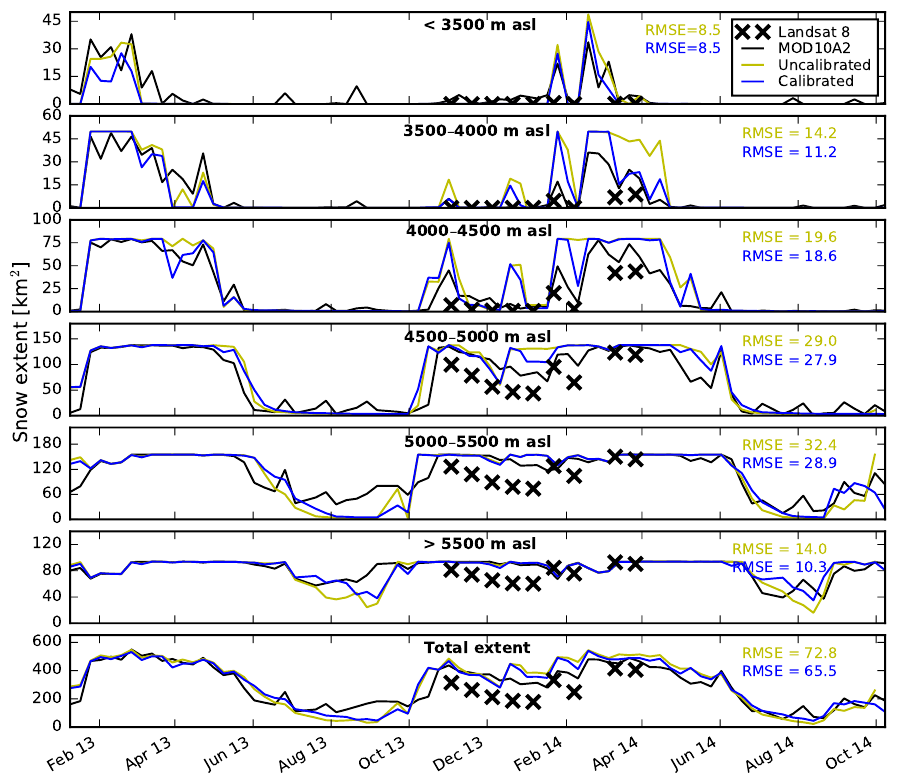
Figure 4. Modeled 8-day maximum snow extent before and after calibration (ensemble mean); Landsat 8 snow extent and MOD10A2 snow extent per elevation zone. The RMSE (km 2 ) is given per zone for the fit between modeled (before and after calibration) and MOD10A2 snow